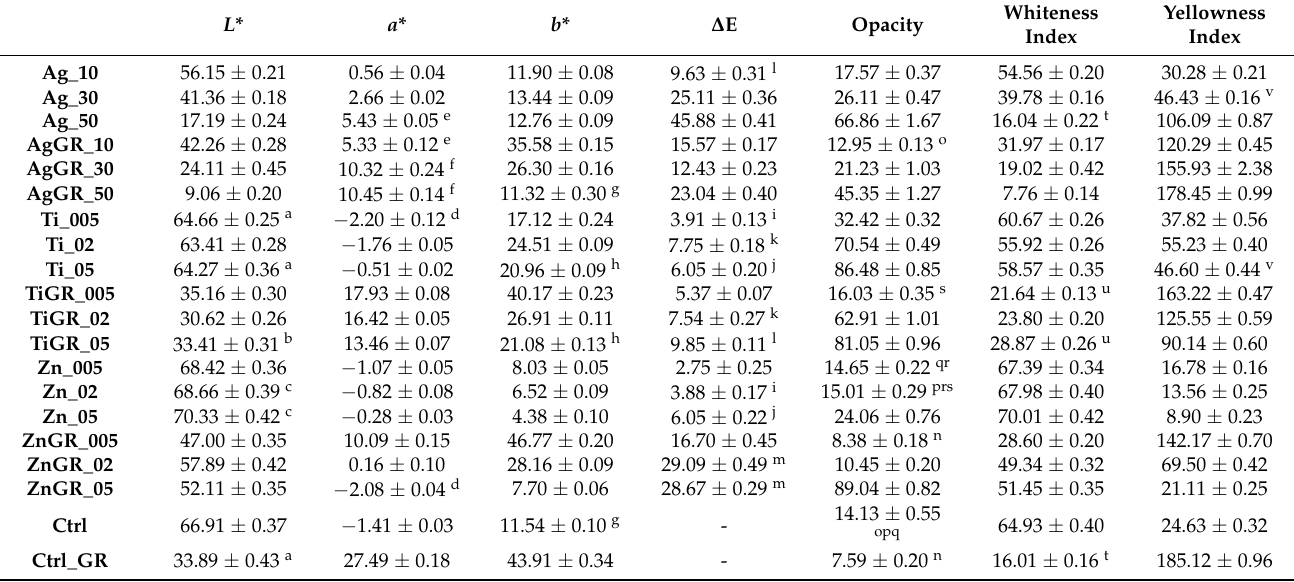
Table 5. Results of evaluation of color properties of packaging.